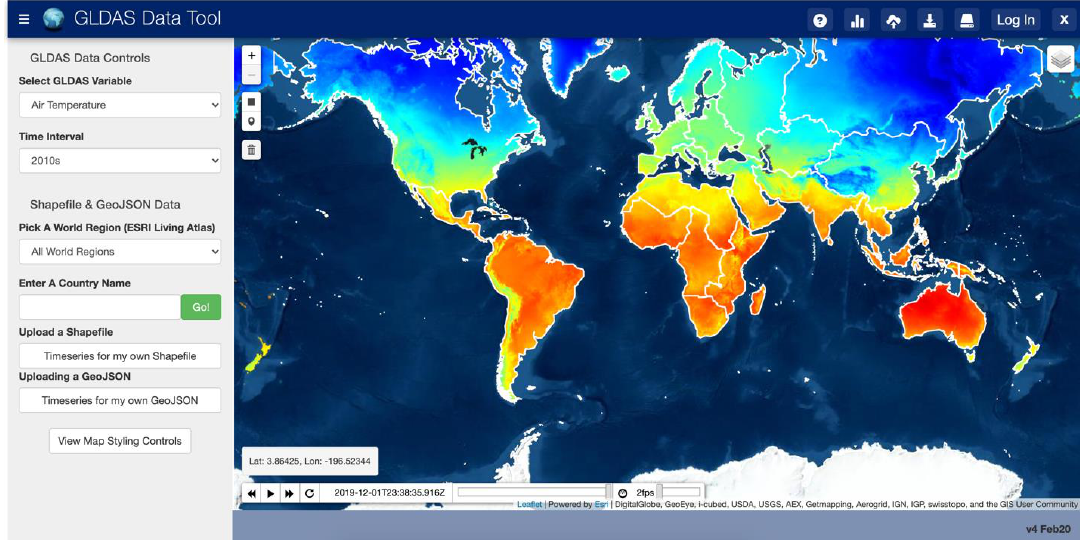
Figure 9. Web App User Interface for GLDAS Data.